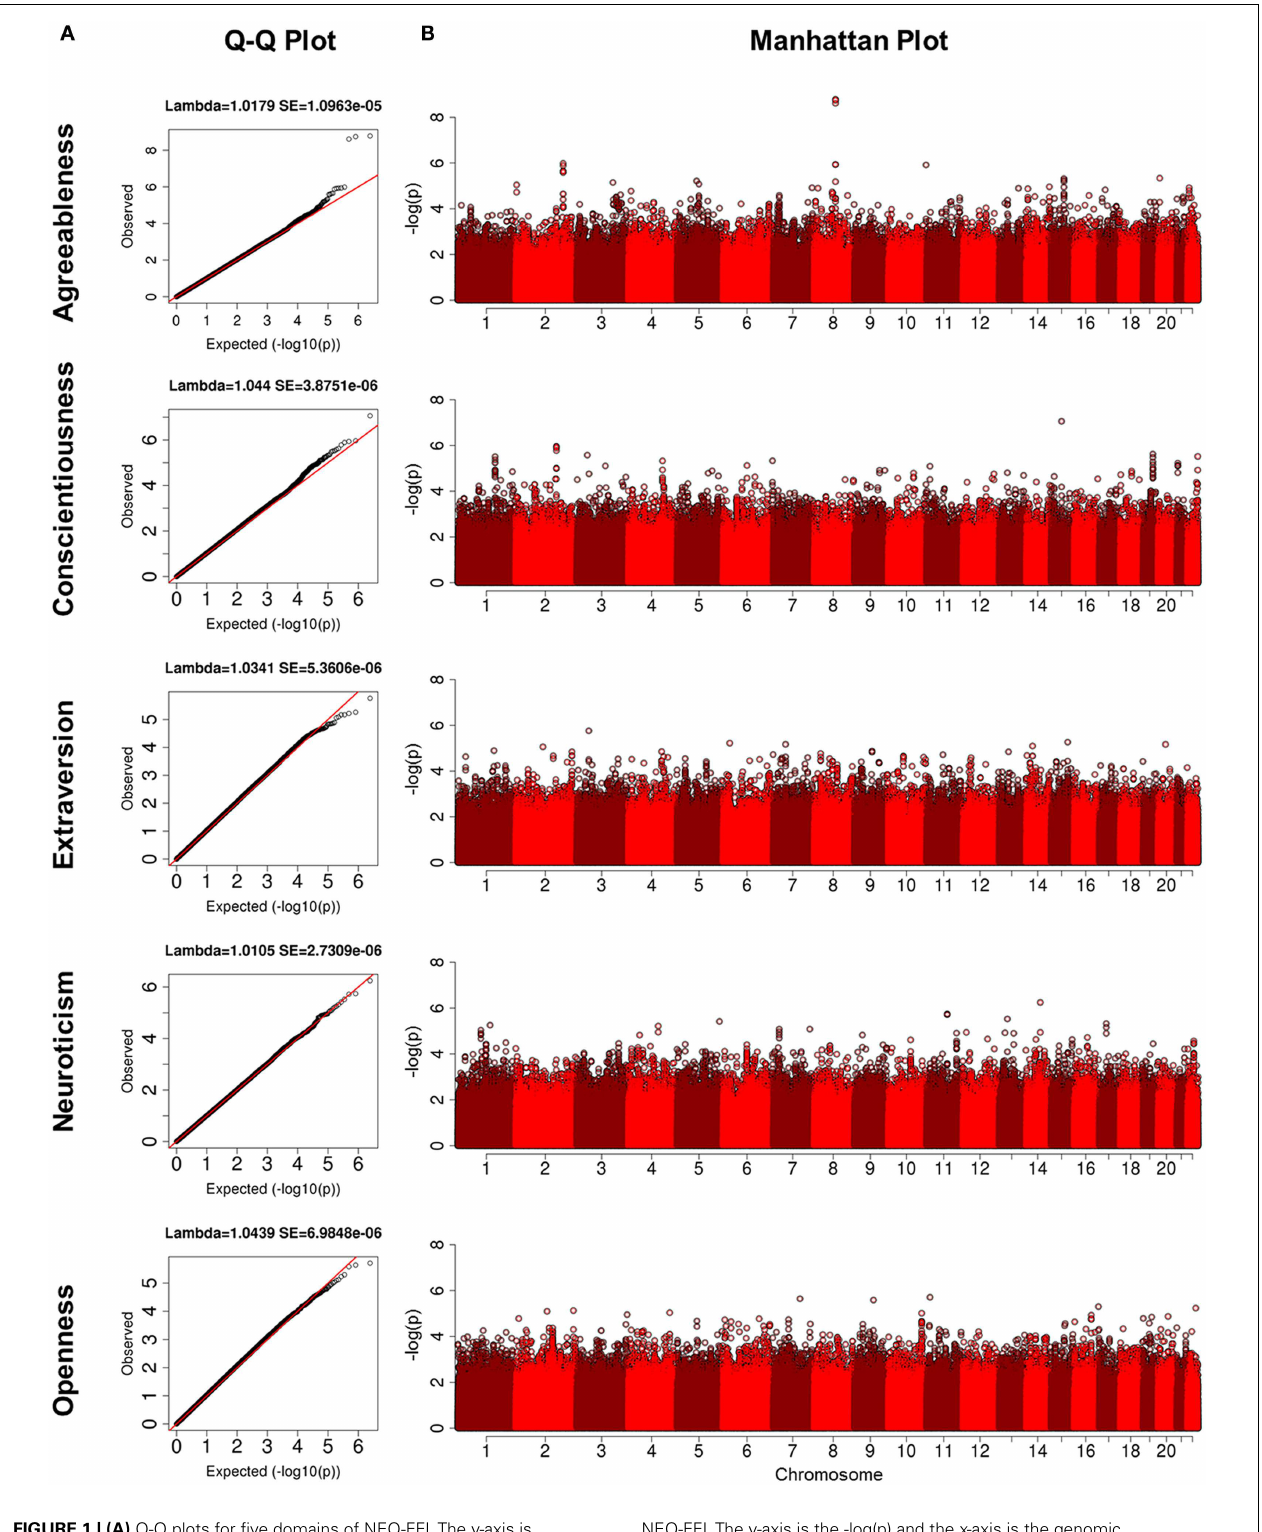
FIGURE 1 | (A) Q-Q plots for five domains of NEO-FFI.The y-axis is the quantiles of observed p-values and the x-axis is the quantiles from the expected distribution; (B) Manahattan plots for five domains of